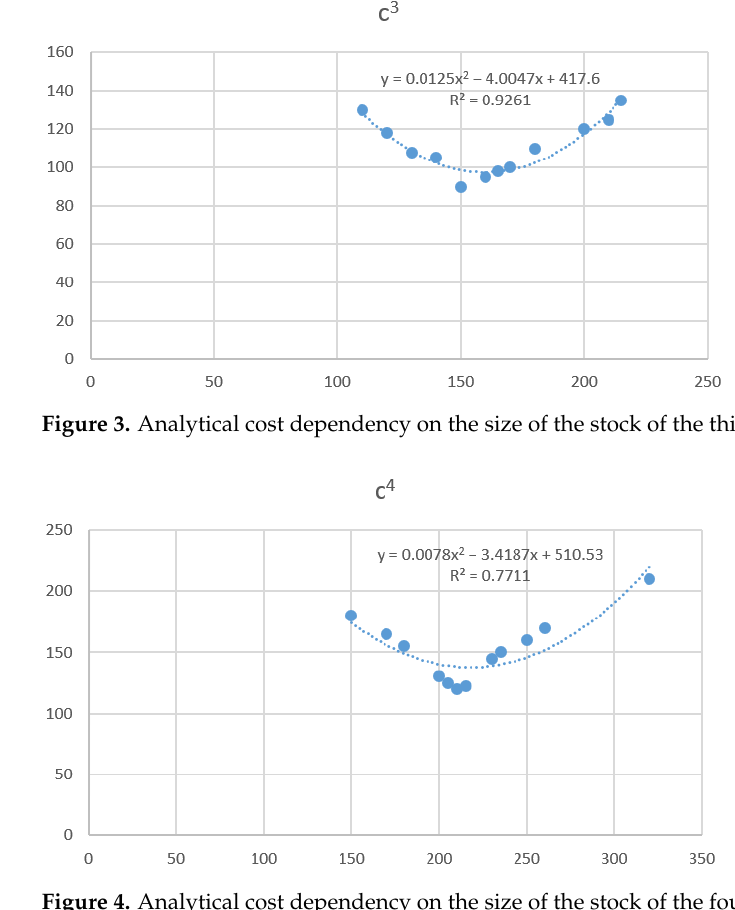
Figure 4. Analytical cost dependency on the size of the stock of the fourth type.